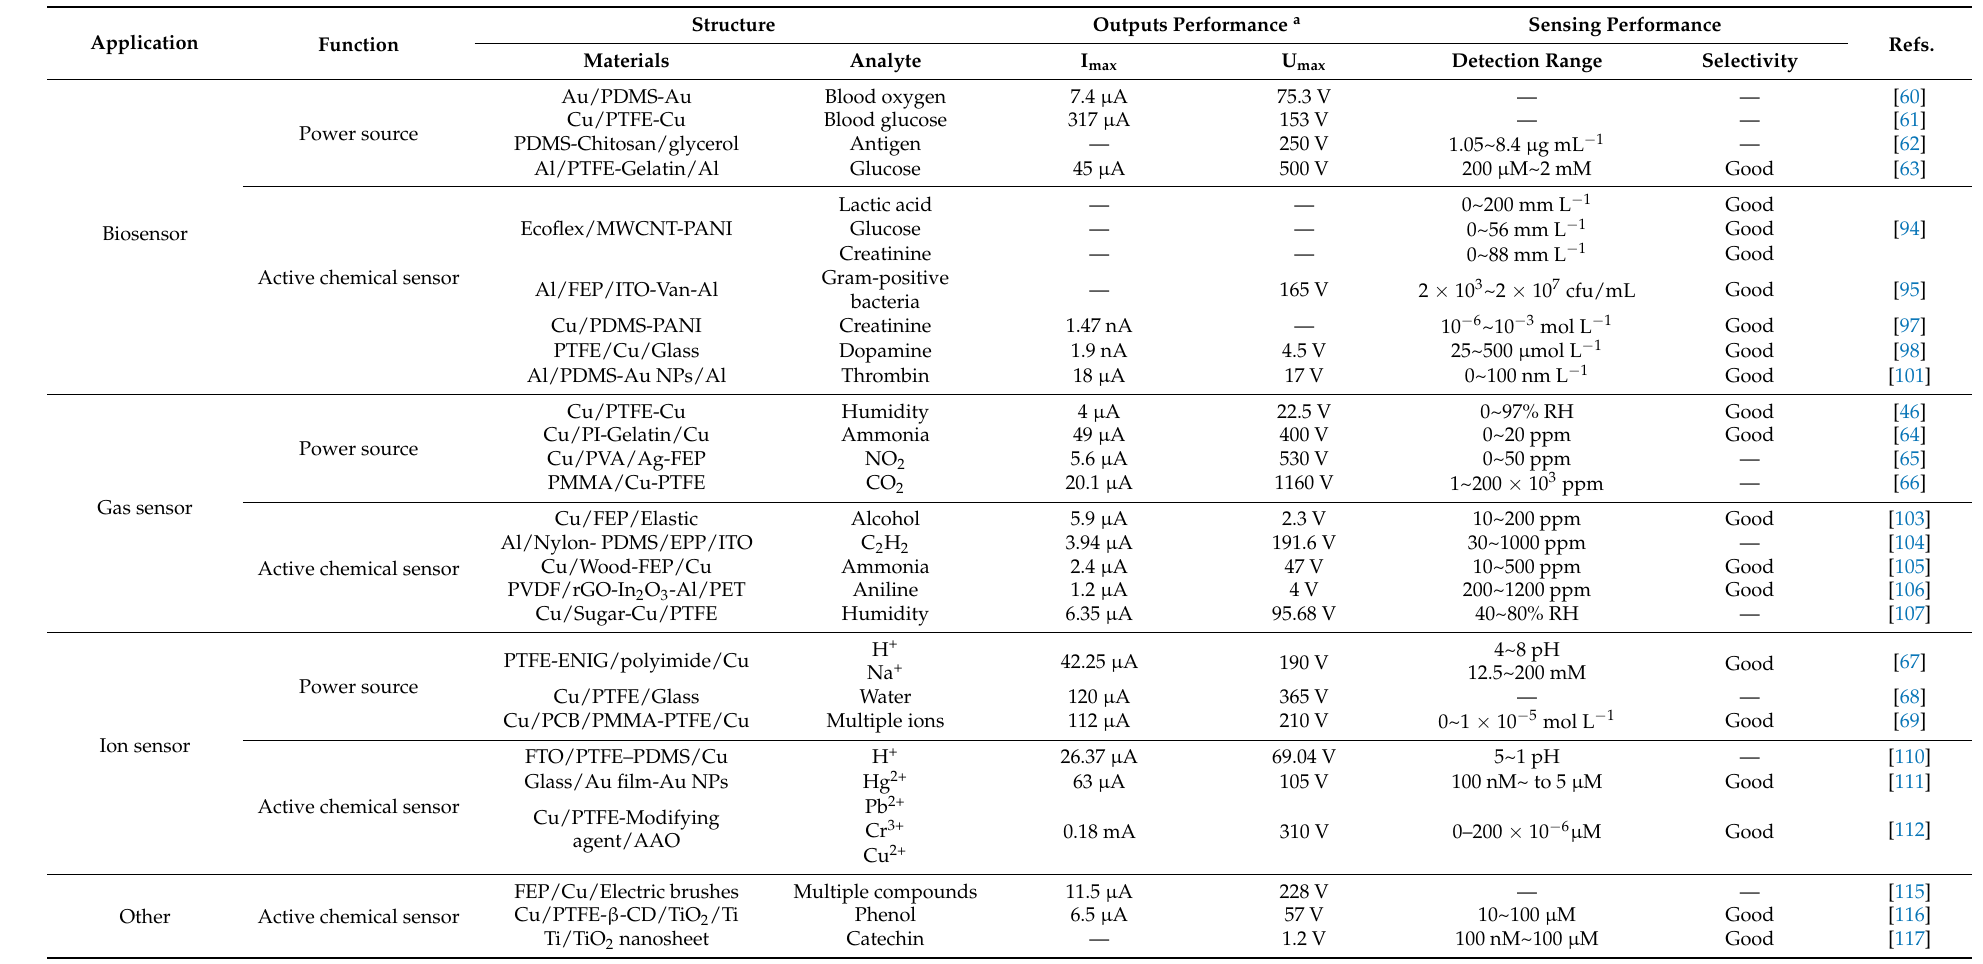
Table 1. Comparison of the characteristics of TENGs as power sources and active chemical